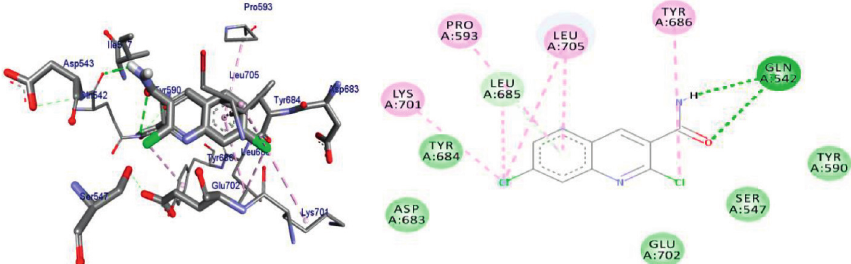
Figure 8: The binding interactions of compound 6 against human topoisomerase II α (PDB ID: 4fm9).